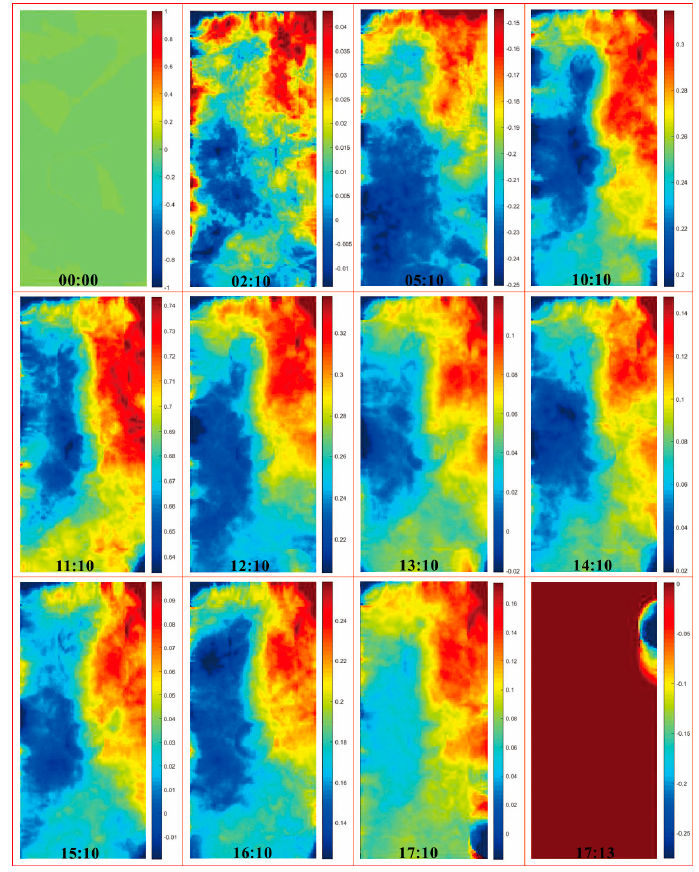
Figure 13. Nephogram maps of axial displacement of C2. Sensors 2021 , 21 , x FOR PEER REVIEW